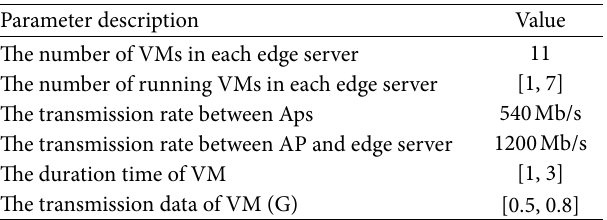
Table 2: Parameter